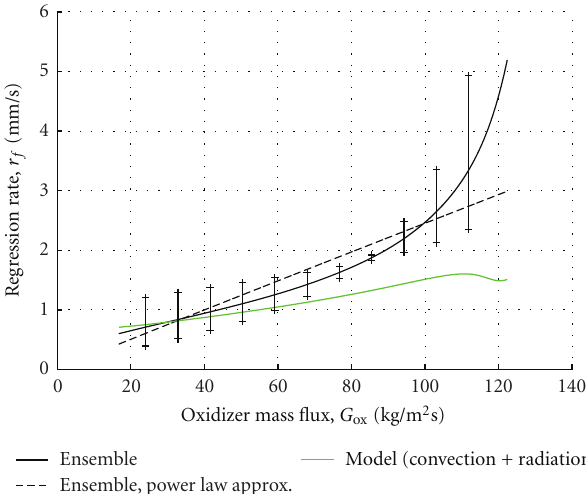
Figure 15: HTPB, loaded with MgB90 (20% Mg): ensemble average of experimental data for r f ( G ox ) with its power law approximation and extended Greatrix model. Note model r f results for G ox ≥ 100 kg/(m 2 s) exhibiting a non-monotonic